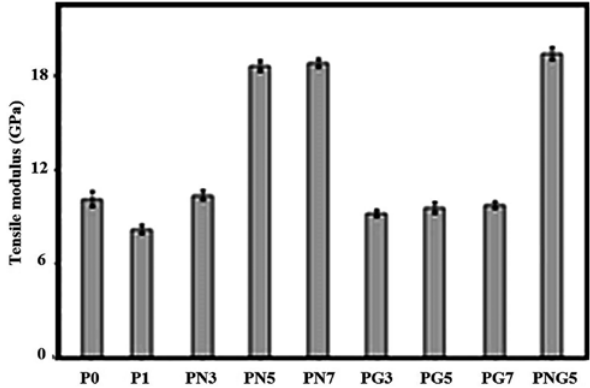
Figure 8: Yield stress of neat PA6 and PA6/PC/NBR blend with and without OC modifier and compatibilizer.